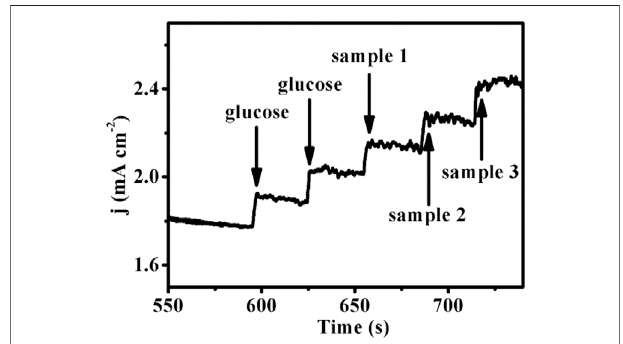
FIGURE 5 | Amperometric response of the Cu-MOF/CF with addition of glucose and three serum samples (glucose: 5 mM, potential: 0.65 V, solution: 0.1 M NaOH).